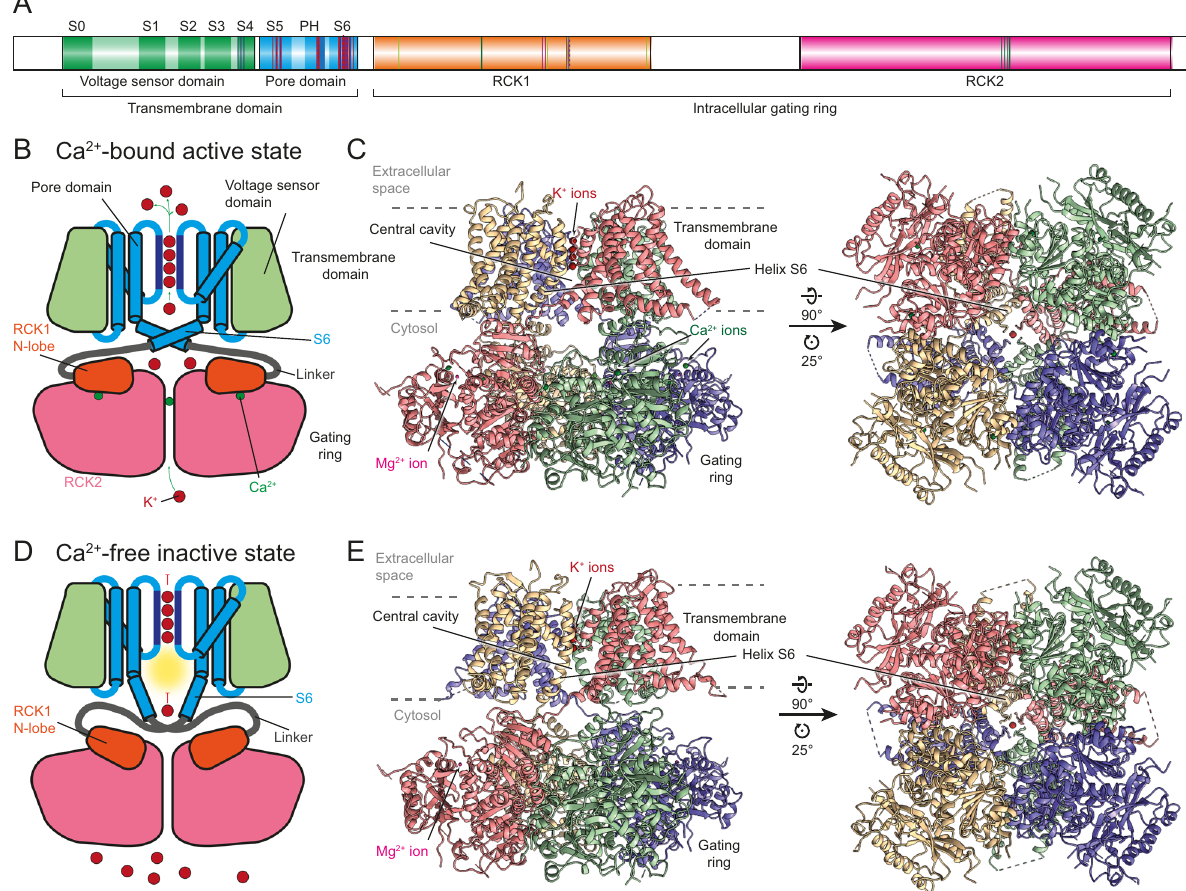
Fig. 1 Drosophila Slo features all conserved hallmarks of Ca 2 + -gated K + channels. A Schematic representation of Slo. The protein comprises an N-terminal TMD consisting of a voltage sensor domain (VSD; green) and a pore domain (PD; blue) that assembles around the central ion conducting channel, and two C-terminal regulatory domains for K + conductance (RCK1 and RCK2; orange and pink, respectively) that constitute the intracellular gating ring. Transmembrane helices in the VSD and the PD are highlighted and labeled. The selectivity fi lter C-terminal of helix PH in the PD is highlighted in darker blue. The three gating charge arginine residues in helix S4 of the VSD are indicated in dark blue. Residues interacting with the two Ca 2 + ions in the gating ring are marked in light and dark green, respectively, and residues involved in Mg 2 + binding in pink. Residues lining the verruculogen binding site in the PD are marked in red, and residues interacting with emodepside in purple. B Schematic representation of Slo in the Ca 2 + -bound active conformation. Ca 2 + ion binding to the gating ring locks the RCK1 N-lobes in an outward-facing conformation. This rearrangement is transferred into the pore domain via the linker between helix S6 and the RCK1 N-lobe, and the C-terminal end of S6 adopts a kinked conformation. As a consequence, the entry to the central cavity is wide and hydrophobic patches along its walls are buried and K + ions can access the selectivity fi lter and be translocated to the extracellular space. C Structure of Drosophila Slo in the Ca 2 + -bound active conformation in two orientations with colors assigned by macromolecular chain to visualize the domain swap between TMD and gating ring. D Schematic representation of Slo in the Ca 2 + -free inactive conformation. Helix S6 of the pore domain adopts a straight conformation that exposes hydrophobic patches along the constricted cavity walls which repulse K + ions. E Structure of Drosophila Slo in the Ca 2 + -free inactive conformation in the same two orientations as in panel C